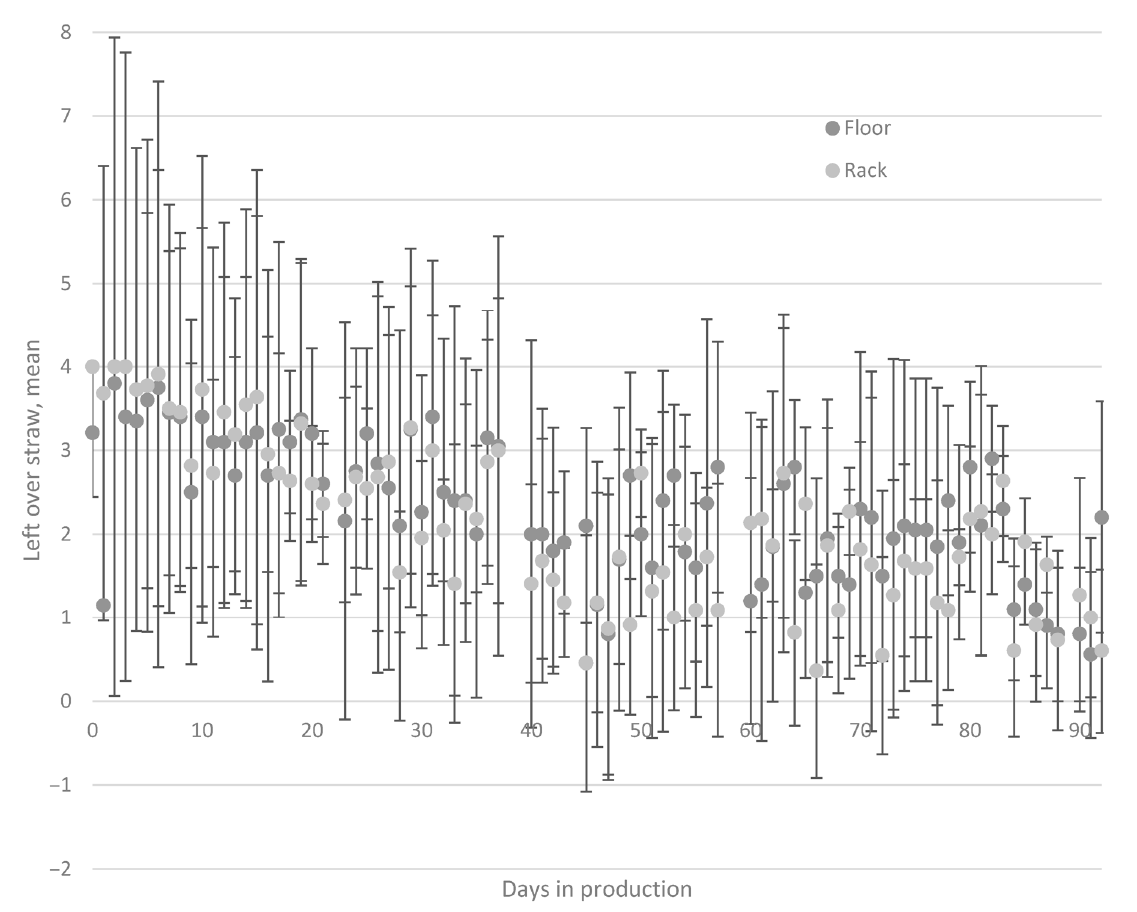
Figure 6. Mean amount of leftover straw and mean standard deviation, in the pen on the daily inspection during the production period. Leftover straw was measured on the floor in the Floor treatment and in the rack in the Rack treatment. n = 2978.